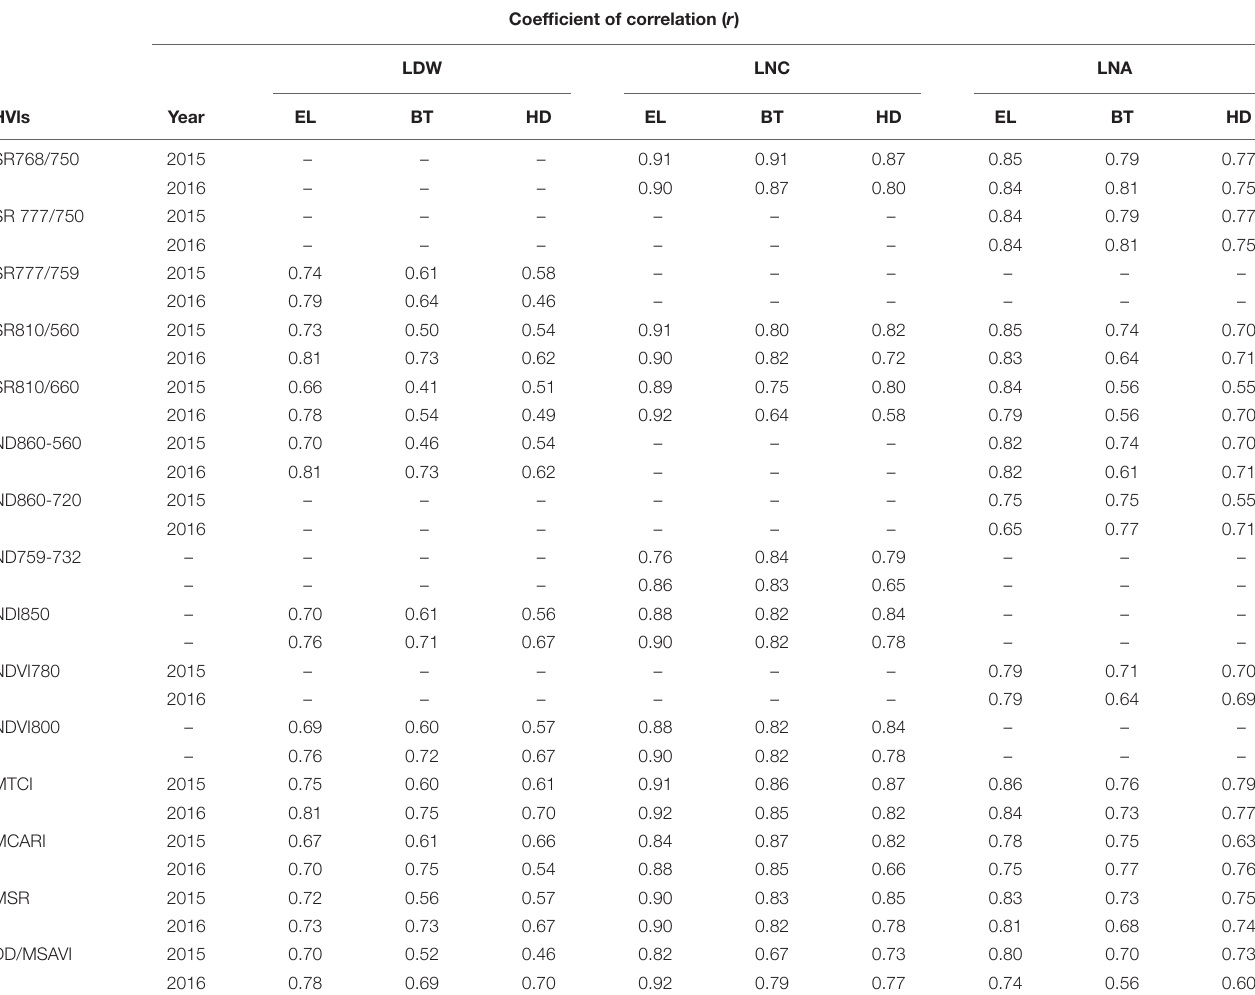
TABLE 3 | Correlation coefficient ( r ) between leaf N status indicators (LDW, LNC, and LNA) over growth stages of rice in 2015 and